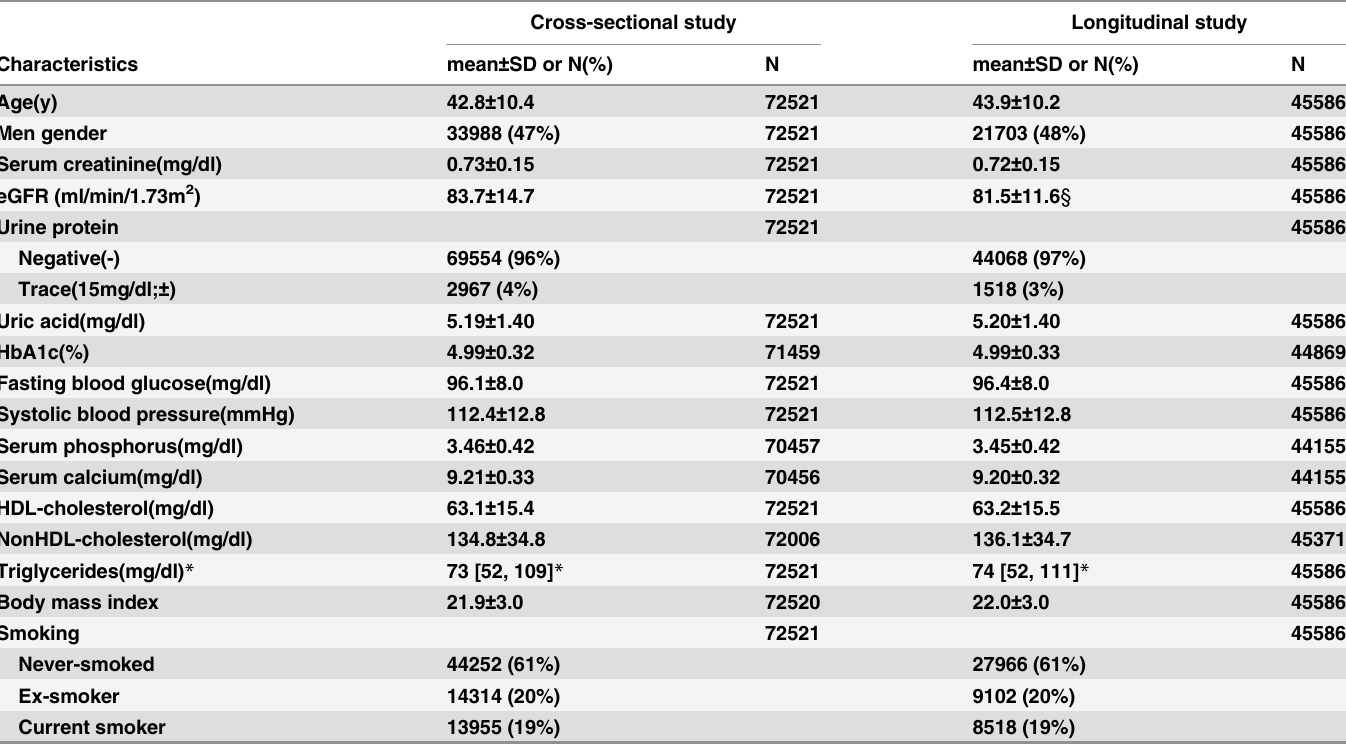
Table 2. Characteristics of healthy subjects in the cross-sectional and longitudinal studies. Cross-sectional study Longitudinal